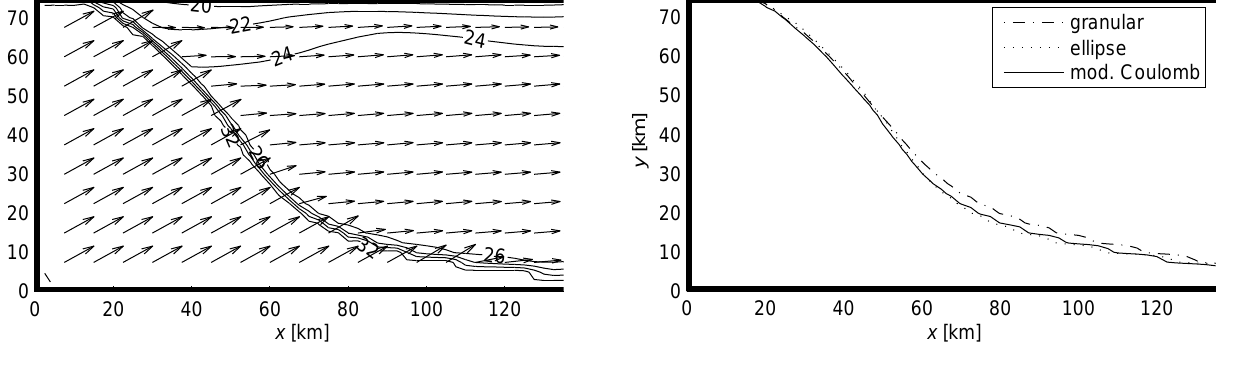
Fig. 7. The polynya edge ( A =0.8) using the elliptic and modified Coulombic yield curves and the granular model after eight model days. The differences between different model formulations are mi-